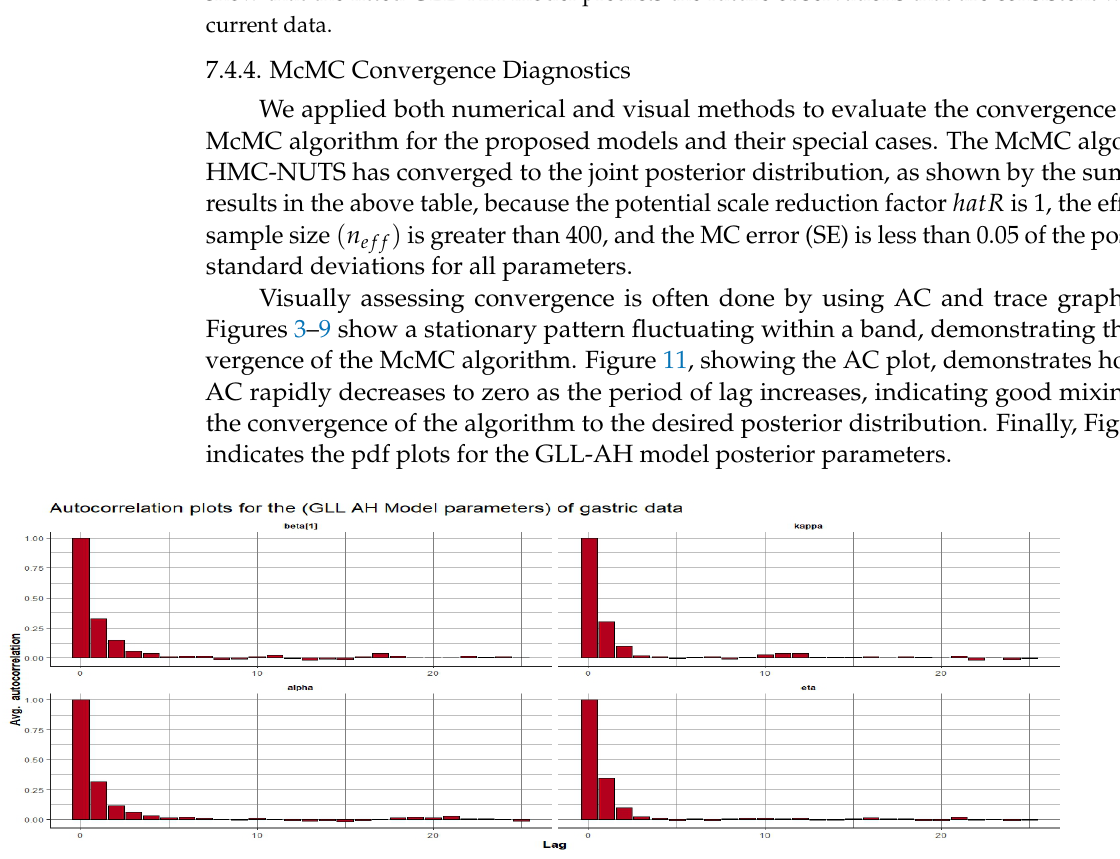
Figure 11. The GLL–AH model posterior parameters AC plots of the gastric cancer